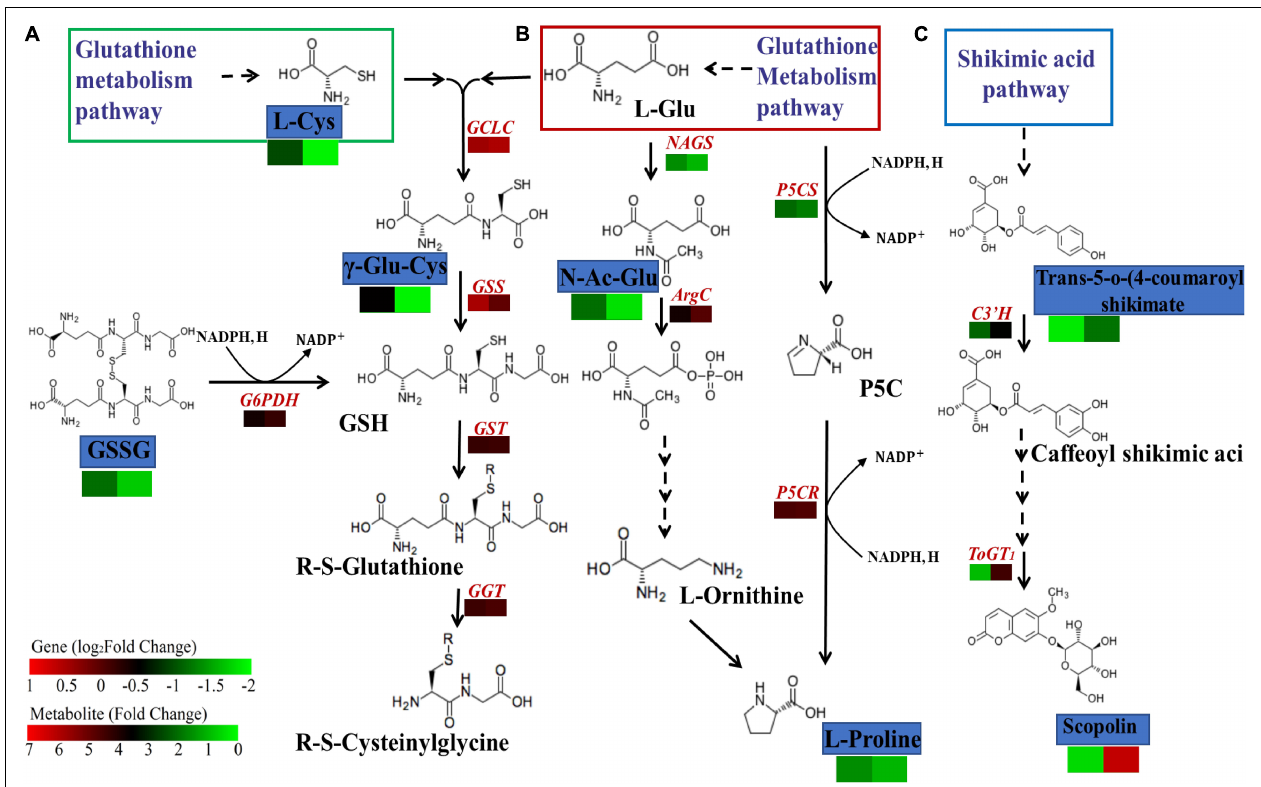
FIGURE 5 | DEGs and DEMs involved in glutathione biosynthesis (A) , amino acid biosynthesis (B) , and shikimic acid (C) metabolism pathway in response to atrazine stress. The rectangles are divided into two equal parts, the left part represents DEGs or DEMs in GA2, whereas the right part represents DEGs or DEMs in LG31. The colors in the rectangles represent the genes or metabolites that were regulated under atrazine stress (red indicates upregulation; black indicates no changes; and green indicates downregulation). GCLC , glutamate cysteine ligase catalytic subunit; GSS , glutathione synthase; GST , glutathione S-transferase; GGT